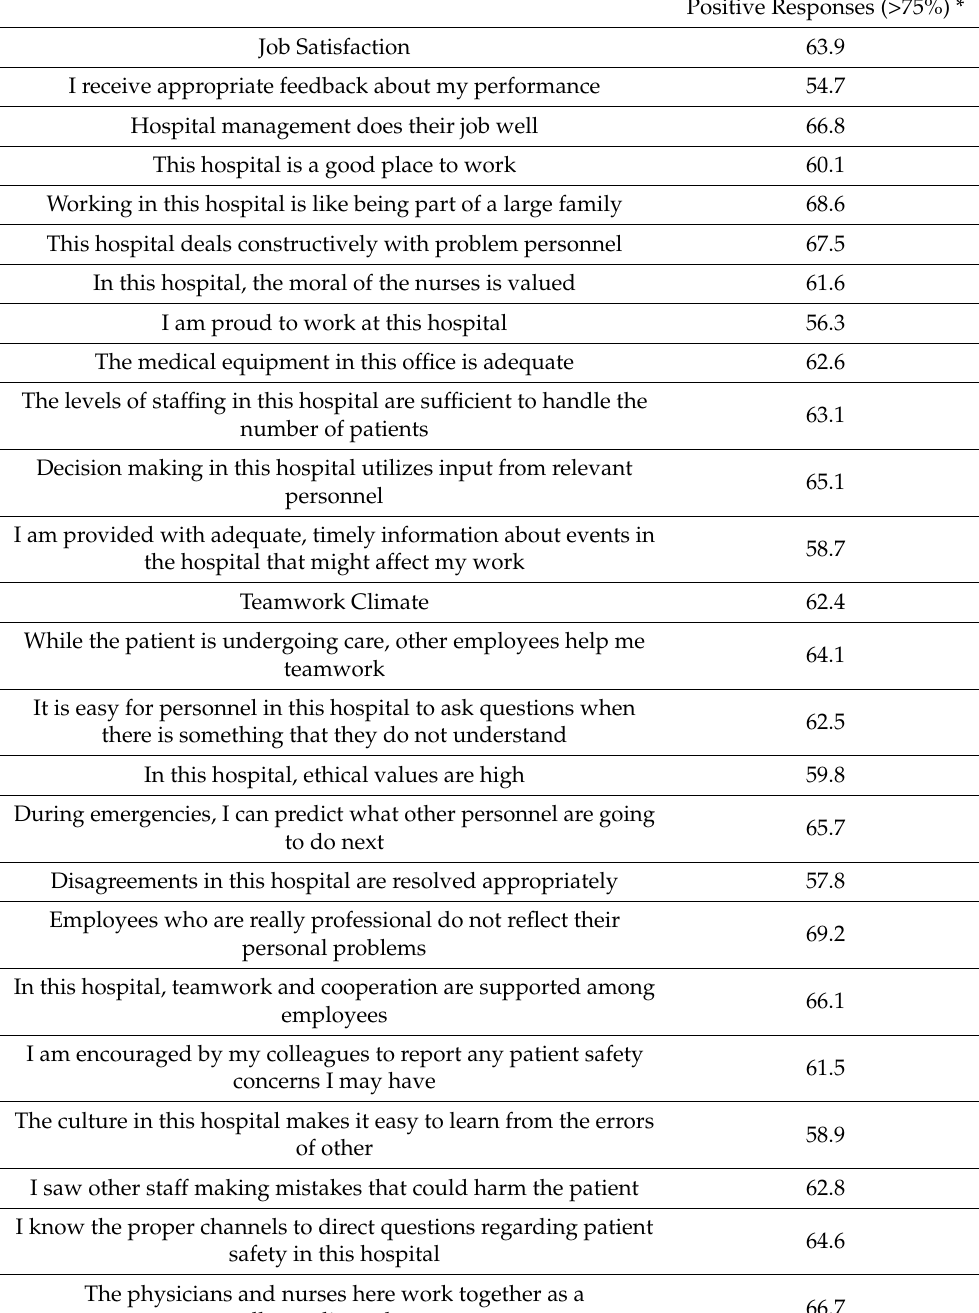
Table 2. Positive Response Percentages of the